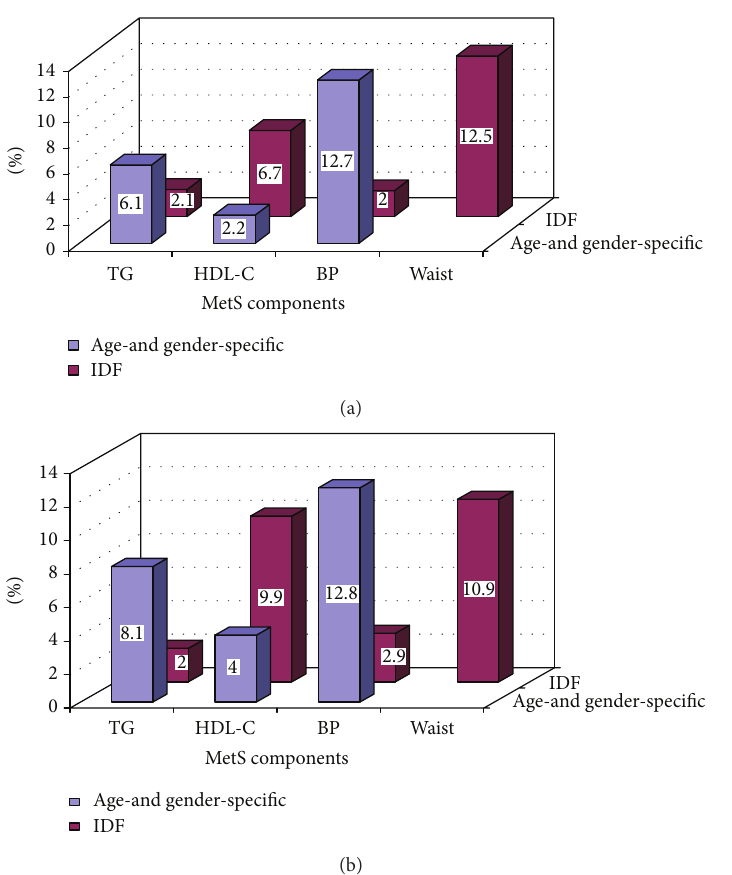
Figure 1: (a) Prevalence of four components of the metabolic syndrome in male first graders depending on IDF, respectively, age- and gender- specific growth curves. (b) Prevalence of four components of the metabolic syndrome in female first graders depending on IDF, respectively, age- and gender-specific growth